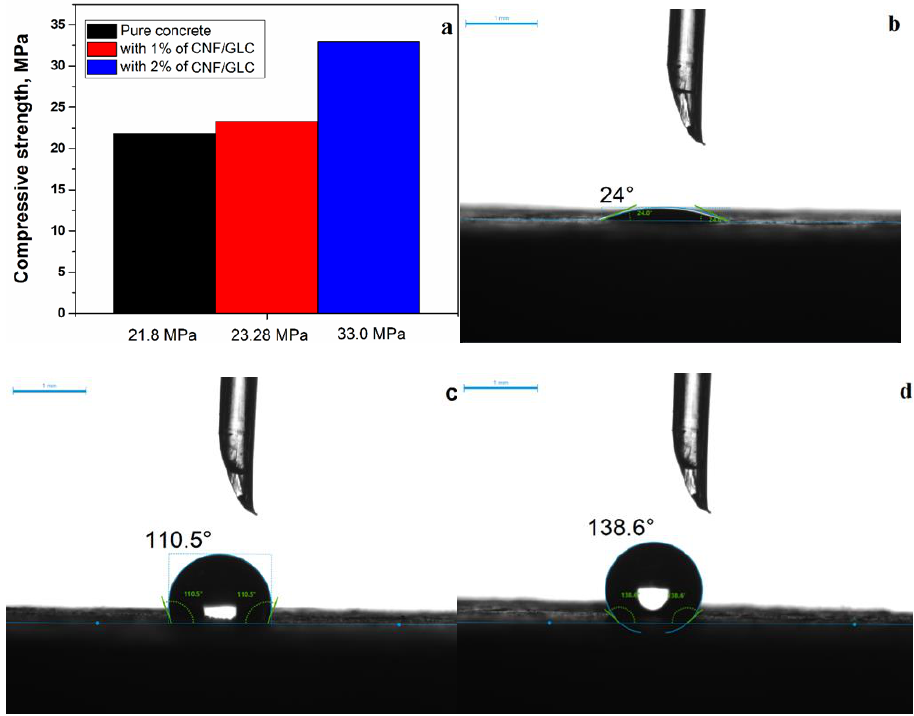
Figure 8. ( a ) Compression strength of CNF/GLC (1 and 2 wt.%) modified concrete blocks compared with pristine concrete block and ( b ) surface-wetting angles of pristine concrete block and ( c ) concrete modified with 1 wt.% and ( d ) 2 wt.% of CNF/GLC .